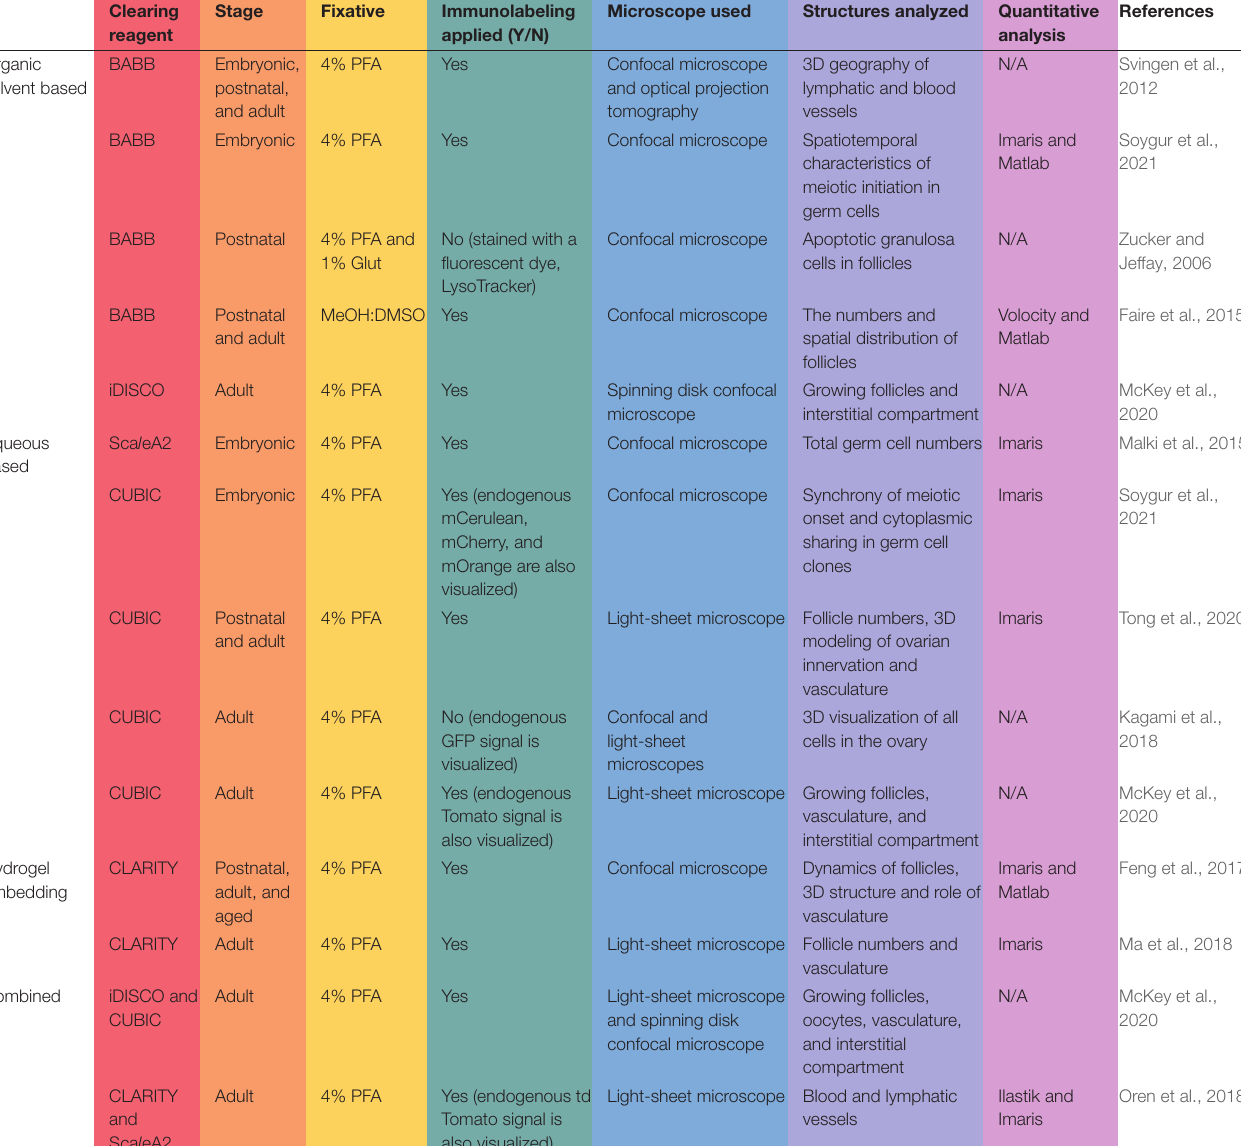
TABLE 1 | Studies that applied different 3D visualization and analysis approaches in mouse